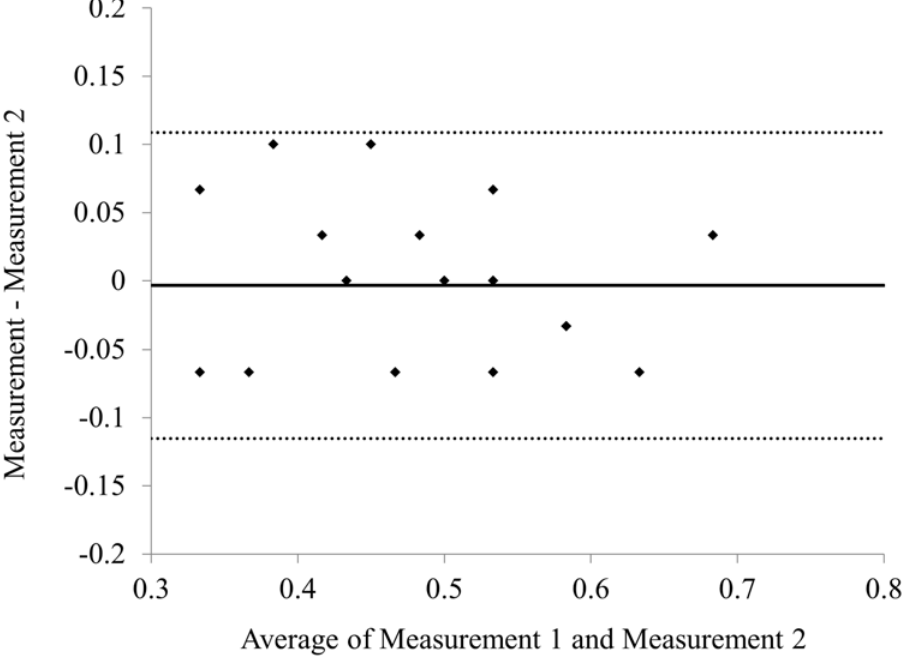
Fig 7. Bland-Altman plots shows the difference between 2 measurements divided by mean of these posterior corneal astigmatism measurements. The solid lines represent mean differences between 2 consecutive measurements of posterior corneal astigmatism, dotted lines are the upper and lower borders of the 95% LoA (mean difference ± 1.96 multiplied by SD of the mean difference).